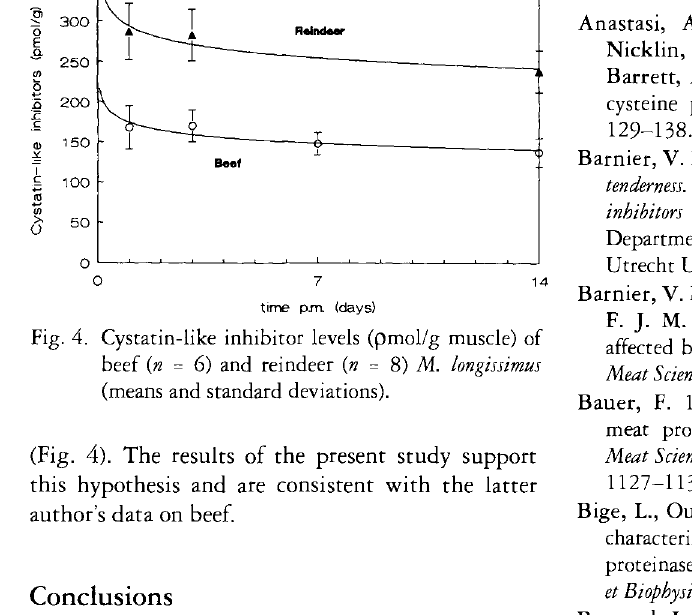
Fig. 4. Cystatin-like inhibitor levels (pmol/g muscle) of beef (» = 6) and reindeer (n = 8) M. longissimus (means and standard